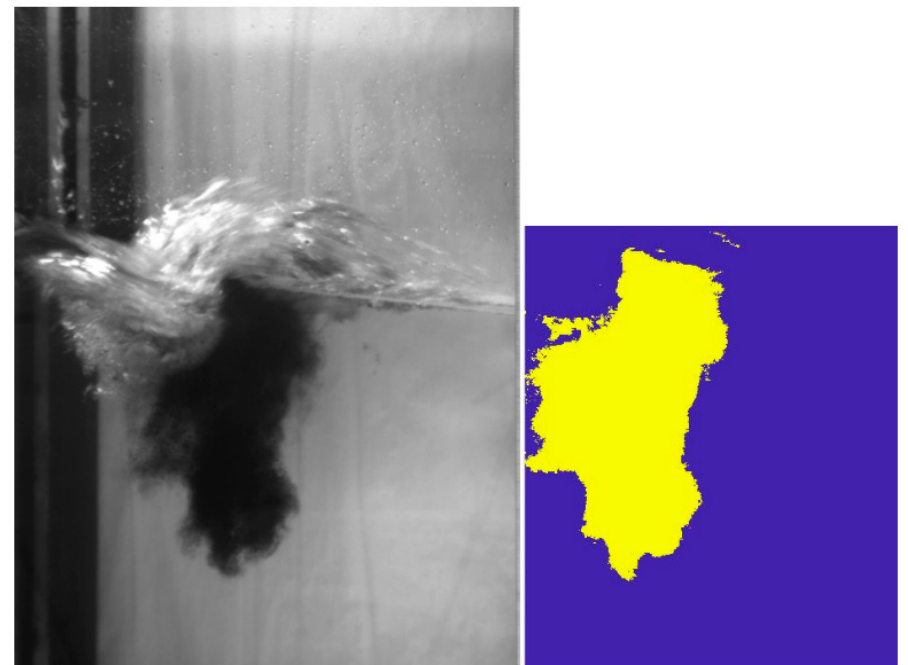
Figure 5. Spilled oil in the observation area was hit by 15 cm breaking wave.